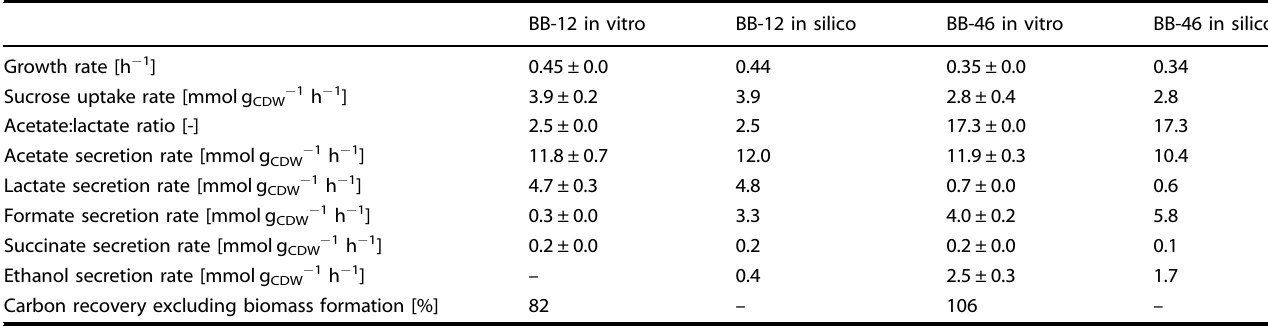
Table 2. Comparison of in vitro and in silico reaction rates for cultivation of BB-12 and BB-46 in the newly formulated chemically de fi ned